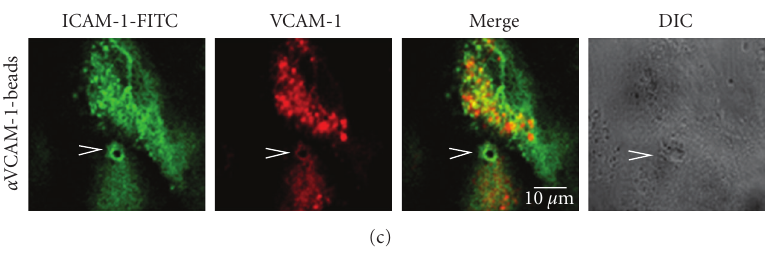
Figure 2: VCAM-1 is recruited to anti-ICAM-1-antibody coated beads. (a) ICAM-1 beads (diameter 3 μ m) were allowed to adhere to TNF α - treated HUVECs. Subsequently, the samples were fixed at the indicated time points and stained as indicated. VCAM-1 is recruited to ICAM- 1 beads (arrowheads) in time. Bar, 10 μ m. (b) Quantification of VCAM-1 recruitment to ICAM-1-induced adhesion sites. The number of adhered ICAM-1-antibody beads that were positive for ICAM-1-FITC staining was set as 100% and percentage of beads that co-localized with VCAM-1 was counted. At 60 minutes adhesion, approximately 80% of ICAM-1 beads that recruited ICAM-1 also recruited VCAM-1. Data are mean ± SEM of three independent experiments. (c) VCAM-1 beads (diameter 3 μ m) were allowed to adhere to TNF α -treated HUVECs and stained as indicated. ICAM-1 is recruited to VCAM-1 beads (arrowheads). Bar, 10 μ